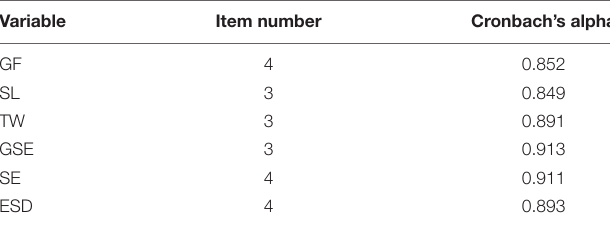
TABLE 2 | Reliability analysis results ( N =